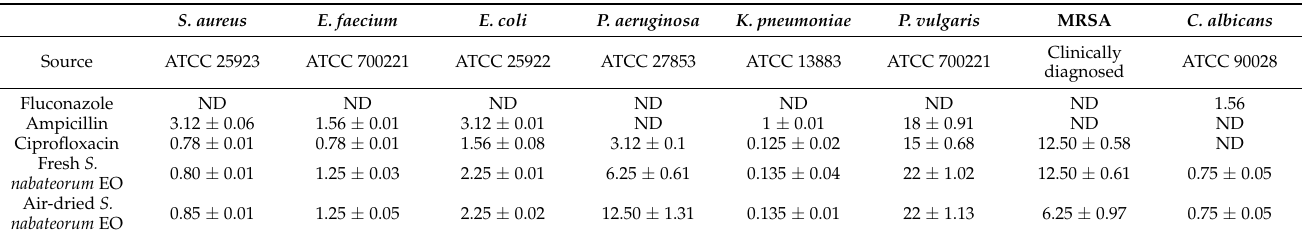
Table 2. Antibacterial and antifungal properties of the essential oils of S. nabateorum (MIC values in µ g/mL).